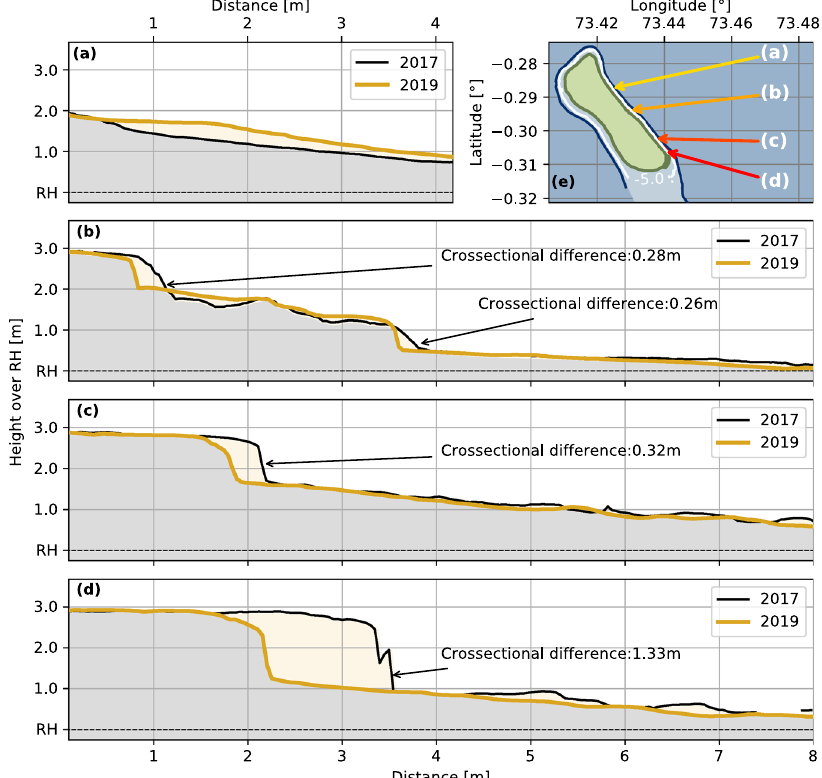
Fig. 2 Erosion along the east coast of Fuvahmulah. Cross-sections of four locations, showing typical coastal pro fi les along the east side of Fuvahmulah. The pro fi les originate from the Digital Elevation Models (DEMs) of the dry season of 2017 and 2019. The DEMs were produced by Agisoft Photoscan with an Structure from Motion-MultiView Stereo (SfM-MVS) approach. a marks the beginning of the beach Thoondu, showing a slight increase of the sandy beach face. b shows a transect from the central area of the east coast, suffering slight erosion of about 0.26 m to 0.28 m at the toe of the beach. Erosion like this can occasionally be measured in other areas of the central east side but it is not constantly detectable along this section of the coast. c and d show pro fi les of the southeastern coast adjacent to the seaport. The steep edge is the transition of the main island into the reef fl at. Here, the coast suffers from constant, structural erosion of about ~0.3 m with maximum values of ~1.33 m between 2017 and 2019 (see Fig. 3). The map in e shows the locations of the pro fi les on Fuvahmulah ’ s east coast. The map is based on data from fi eld measurements and adapted publicly available © OpenStreetMap contributors data, accessed through the open-access Geofabrik download